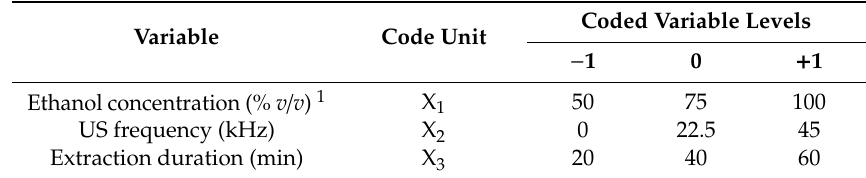
Table 1. Identity, code unit, coded levels and actual experimental values of each variable used for UAE of TFC from N. lotus